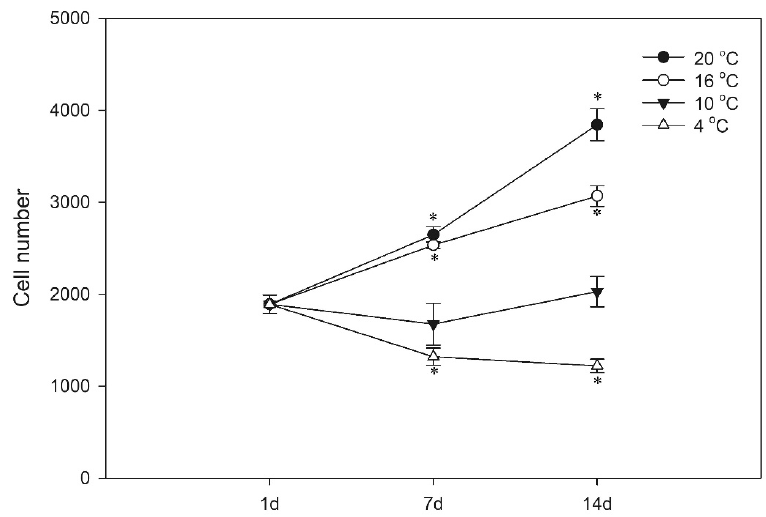
Figure 3. Cell proliferation. The cells were plated at different densities and grown for 1, 7 and 14 days (d) at different temperatures, as indicated. The data are representative of three independent experiments and are expressed as mean ± SD of four parallel incubations. * indicates significantly different from day